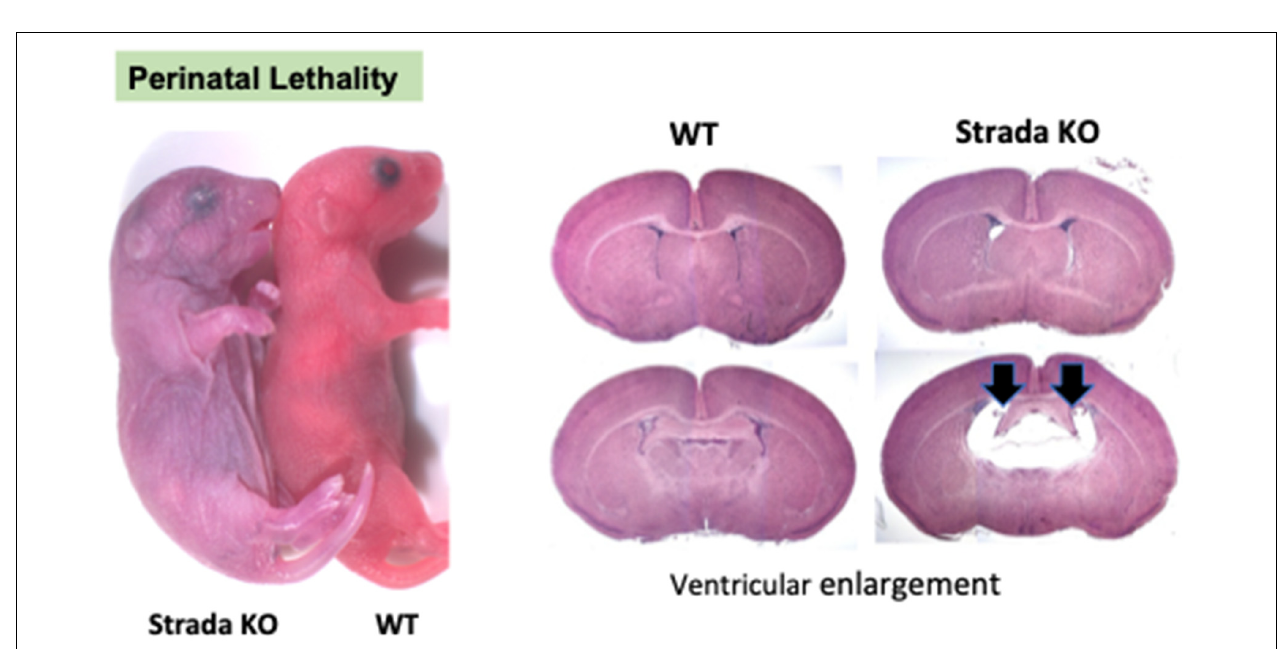
FIGURE 8 | Perinatal lethality in Strada − / − mice. Left, a comparison of Strada − / − to wildtype (WT) mouse pup. Right, evidence of ventricular enlargement (arrows) in P10 Strada − / − mice.